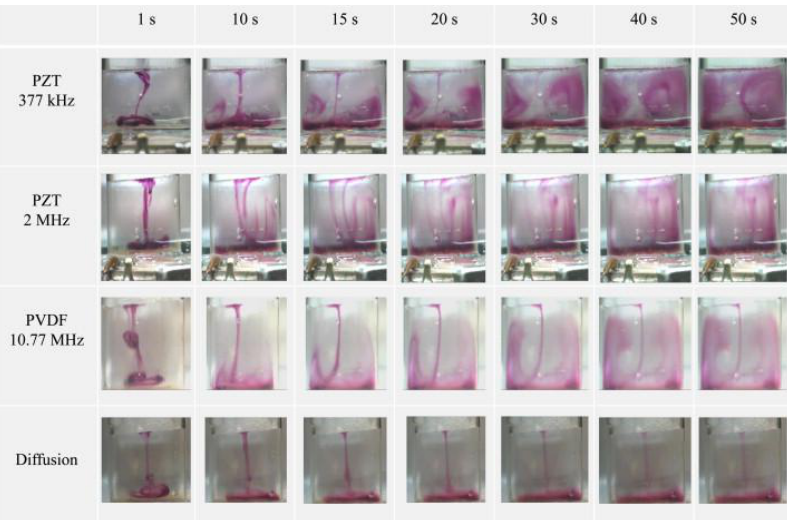
Figure 4. Movie frames of the experimental qualitative evaluation of a mixture between water and a dye with and without acoustic actuation. As proof of concept, a cuvette with dimensions of 8 mm width × 7 mm height × 2 mm thickness was used and actuated by PZT and β-PVDF transducers placed underneath, driven by a 24 Vpp sinusoidal voltage. Reproduced with permission [220].